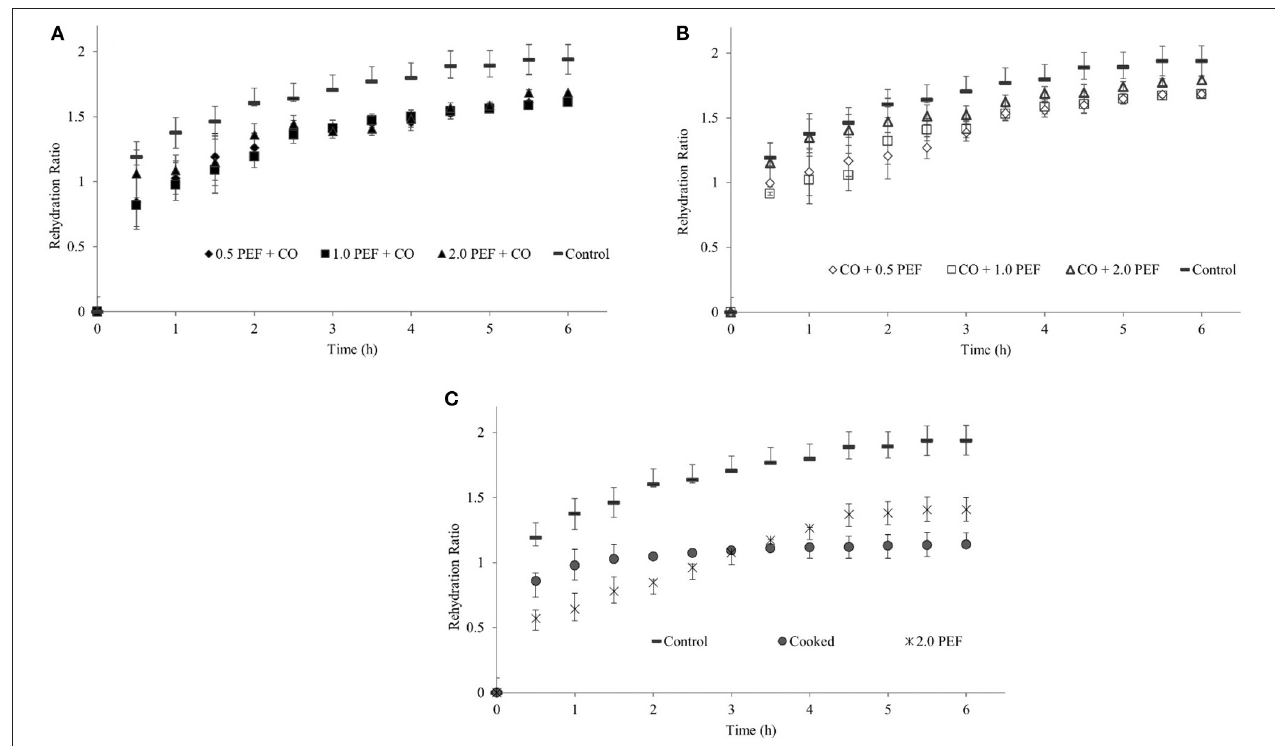
FIGURE 2 | Rehydration kinetics of freeze-dried samples under different pretreatment conditions: (A) PEF + CO pretreated samples compared to control sample, (B) CO + PEF pretreated samples compared to control sample, and (C) 2.0 PE or CO pretreated samples compared to control